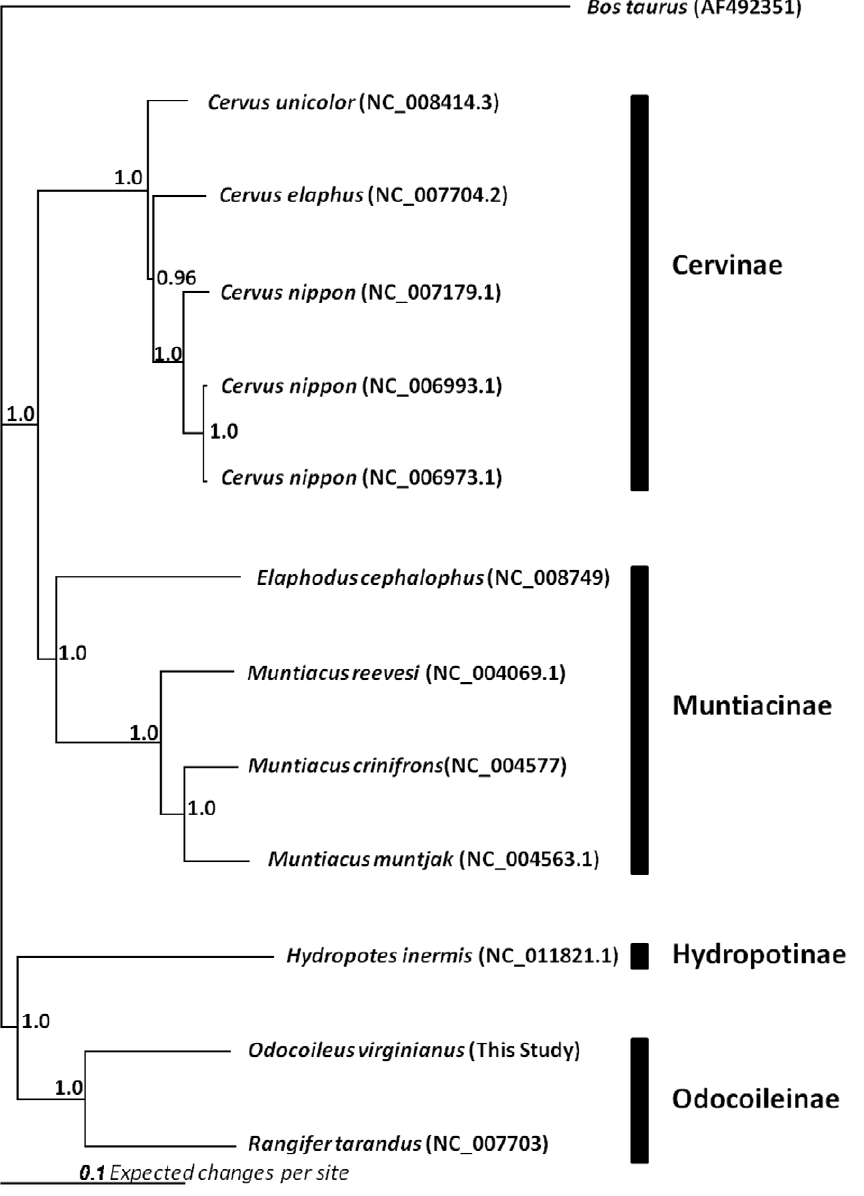
Figure 3. Mitochondrial Phylogeny. Majority rule consensus phylogenetic tree for 10 species of Cervidae inferred from concatenated 12S rRNA , 16S rRNA , ND1 , ND2 , COX1 , COX2 , ATP8 , ATP6 , COX3 , ND3 , ND4L , ND4 , ND5 , ND6 , and CYTB gene sequences. Entries in parenthesis represent Genbank Accession Numbers. The Odocoileus virginianus consensus sequence was derived from this study. Start codons, stop codons, and overlapping regions of genes were excluded. Numbers beside branches indicate posterior probabilities estimated from a Bayesian analysis employing 2 6 10 6 generations [35].